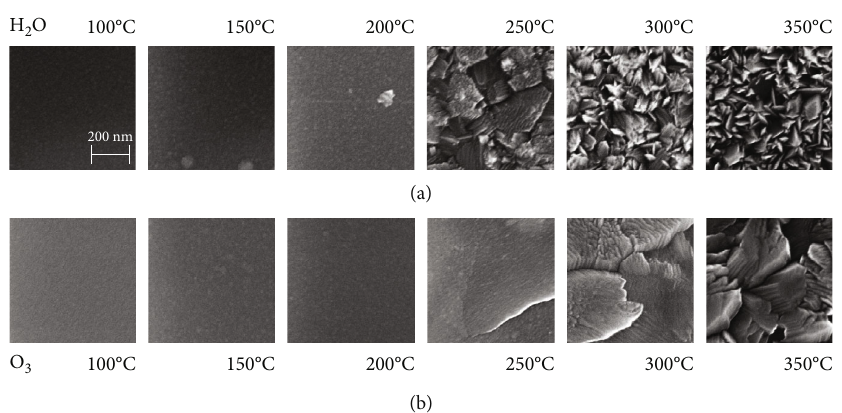
Figure 3: SEM images of TiO